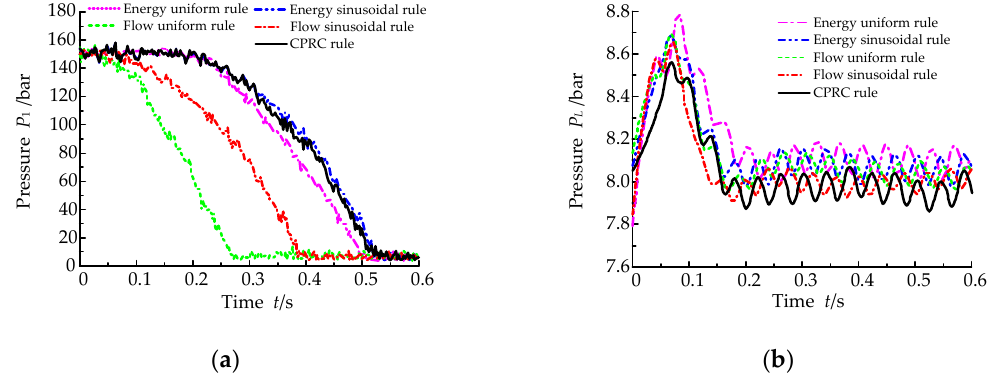
Figure 15. The system response curve under initial pressure of 150 bar: ( a ) Working cylinder pressure; ( b ) Relief-pipe pressure.